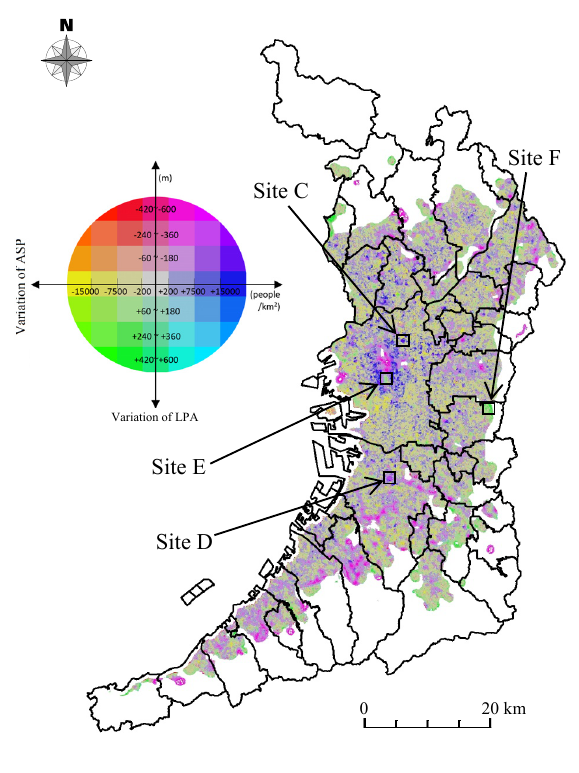
Figure 10 . Spatial variation map of local populations among 1995 and 2015 in